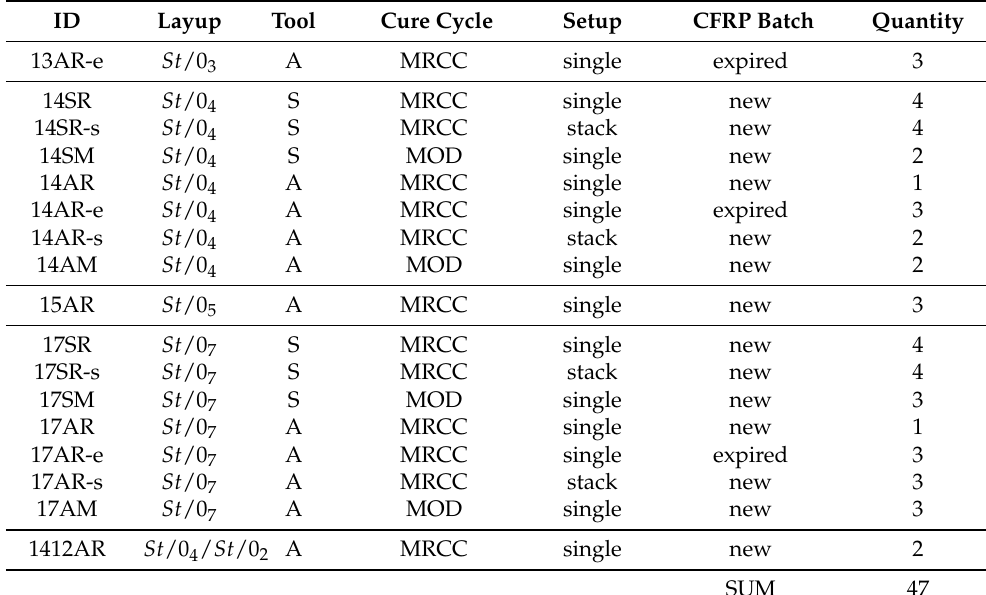
Table 5. Overview of the specimen program and its parameter variations in this work. ID Layup Tool Cure Cycle Setup CFRP Batch